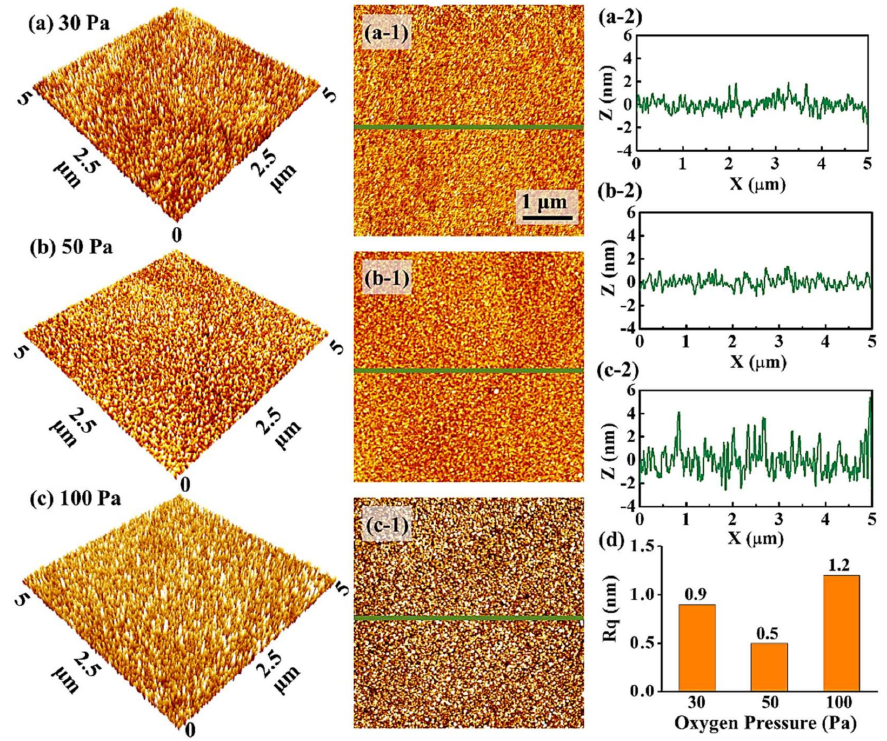
Figure 7. AFM side-views (5 × 5 µ m 2 ) of PLZT thin films fabricated on MgO (200) by varying the annealing oxygen pressure: ( a ) 30; ( b ) 50; and ( c ) 100 Pa; ( a-1 – c-1 ) the corresponding top-views of 5 × 5 µ m 2 ; ( a-2 – c-2 ) cross-sectional line-profiles acquired from the area drawn with the green line in ( a-1 – c-1 ); and ( d ) the R q values of the samples annealed at different oxygen